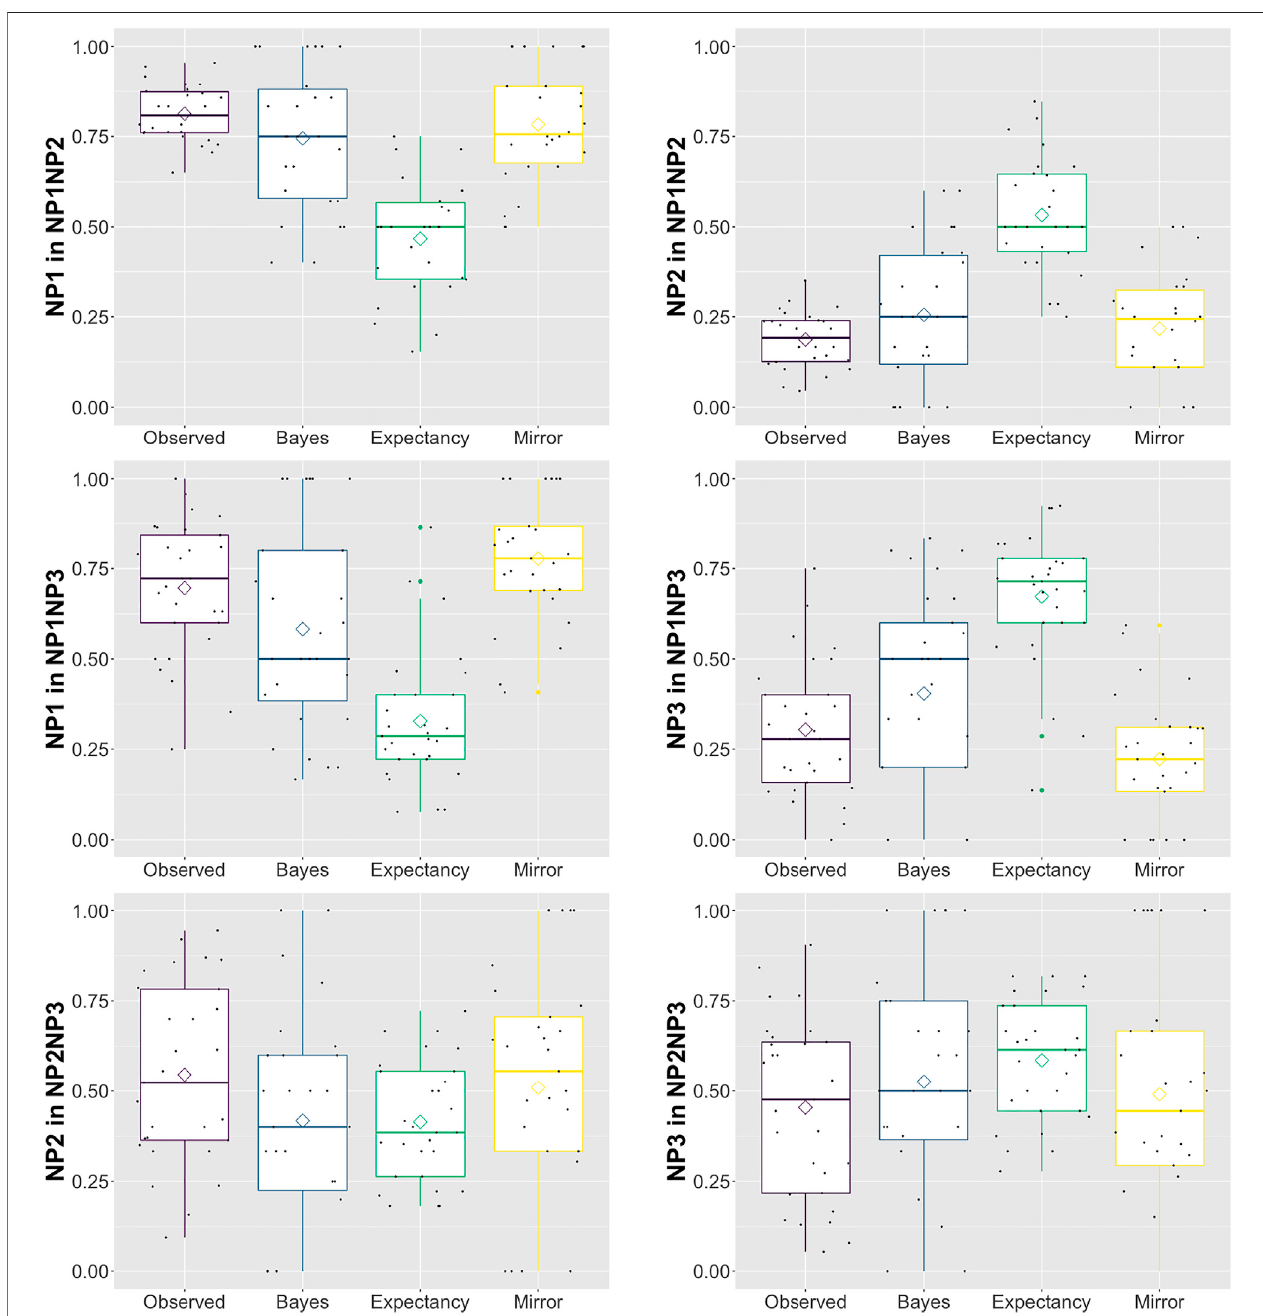
FIGURE 1 | By-item observed values and model estimates for each referent in each ambiguous pair in Experiment 1. Tilted squares indicate the means. Random jitter has been added to the individual data points to avoid overplotting.